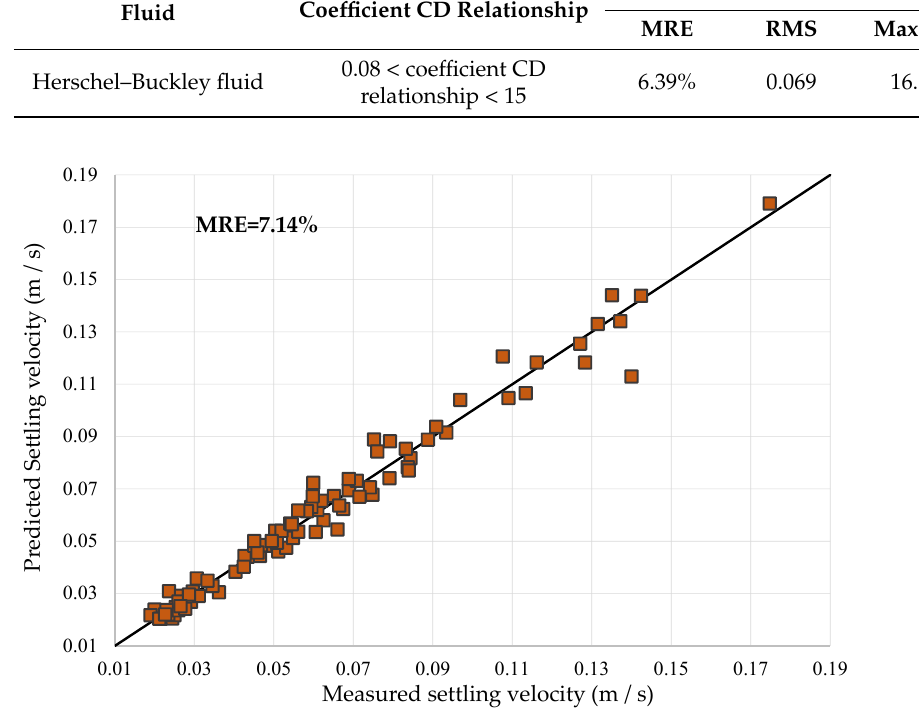
Figure 13. Comparison results between experimental measured values and model predicted values of shale cuttings settlement velocity.